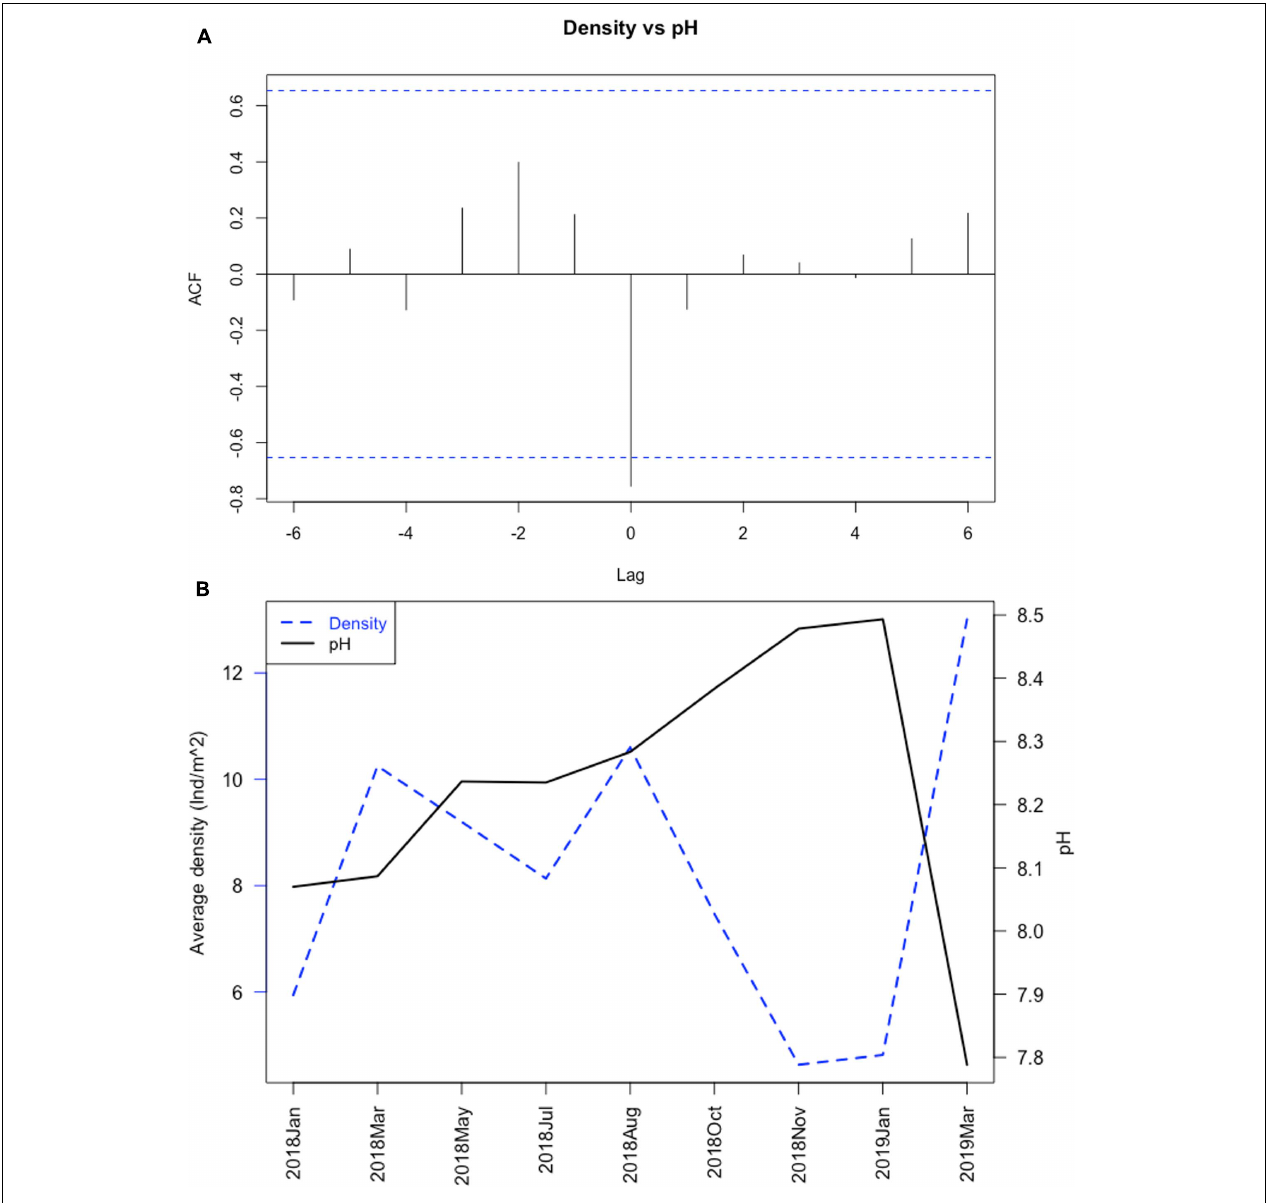
FIGURE 7 | Cross-correlation analysis for the time series of pH of the water column and mean density of Holothuria mammata , at Arrábida, Setúbal, during the nine month sampling period: (A) ACF plot depicting correlations (vertical lines) and significance threshold (horizontal dotted lines); (B) average monthly values for pH and